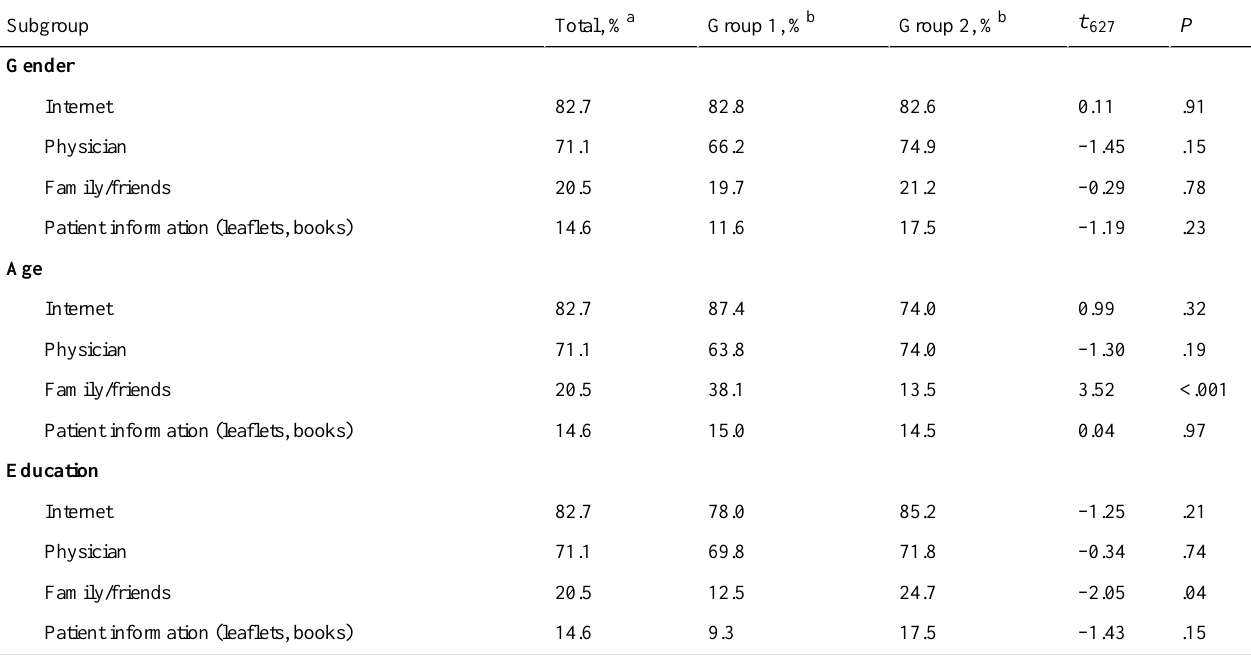
Table 2. Sources for health-related